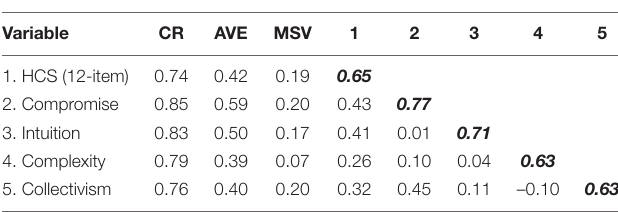
TABLE 5 | Study 2 – validity analysis of the 12-item HCS.